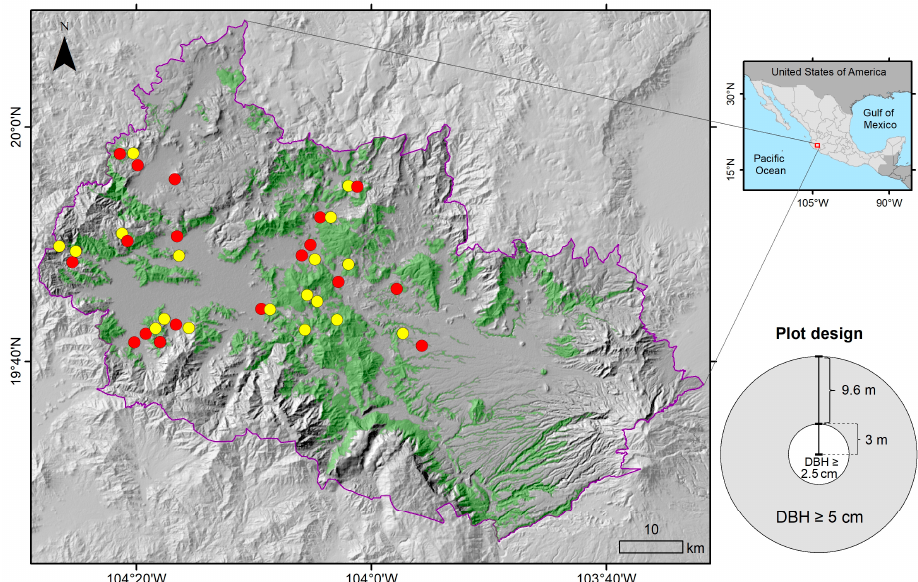
Figure 1. Study area and sampling plot locations. The background image is a digital elevation model (DEM) obtained by Shuttle Radar Topography Mission (SRTM) presented in shaded relief. Areas in green correspond to tropical dry forest in the study area. The purple line indicates the boundary of the watershed of the Ayuquila River. The red triangles indicate sampled plots of degraded forest and the yellow dots conserved forest.